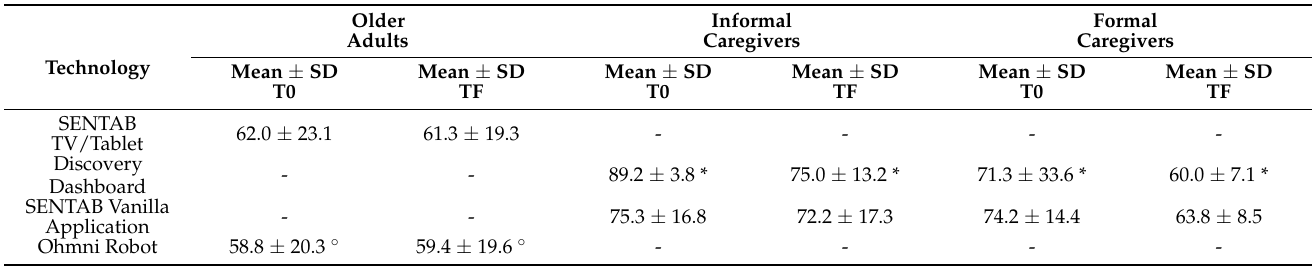
Table 9. SUS results in Phase 2 of pre-validation. The sample for the SENTAB TV/tablet consisted of ten older adults. The sample for the Discovery Dashboard consisted of four informal caregivers and two formal caregivers. The sample for the SENTAB application consisted of nine informal caregivers and seven formal caregivers. The sample for the Ohmni robot scenario consisted of five Older